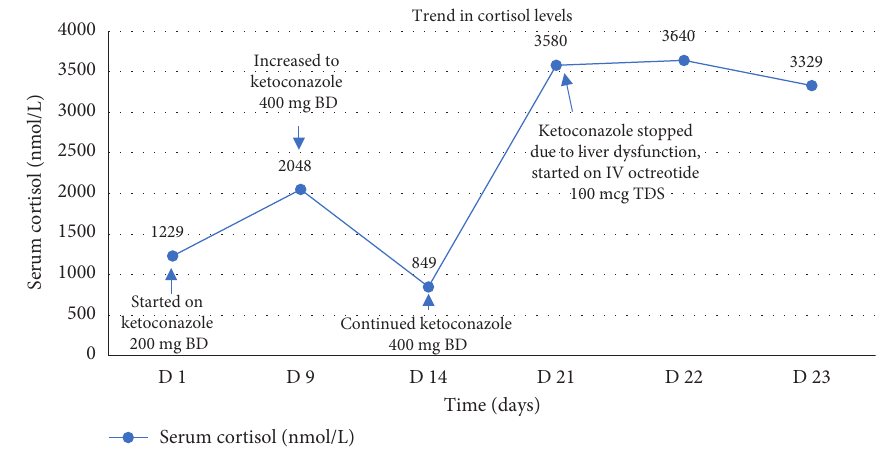
Figure 5: The trend in cortisol levels on pharmacological